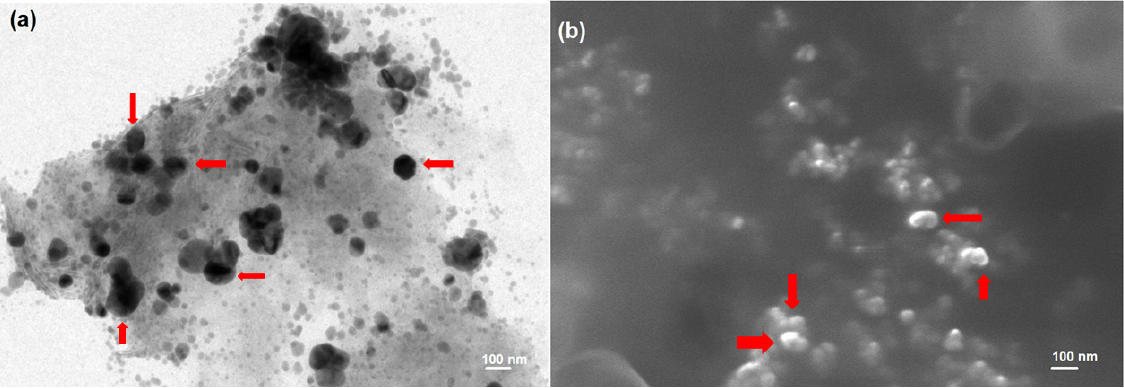
Figure 1. ( a ) TEM image of the ALT-HA-NPs and ( b ) SEM image of ALT-HA-NPs image, red arrows indicate NPs.